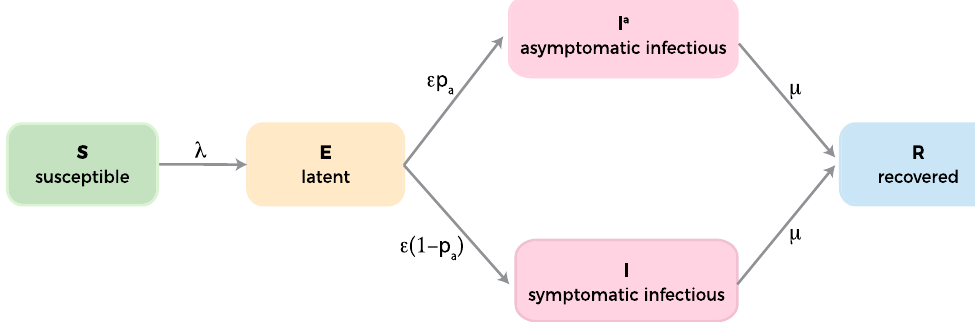
Figure 2. Flow diagram of the SEIR transmission model (boxes represent an SEIR compartment state and arrows represent the rate of transition from one state to another). A susceptible individual in each subpopulation (network node) contracts the infection at rate (cid:31) and enters the latent compartment. The individual is infected 1 but not infectious during the latent period ( ǫ − days). Latent individuals subsequently transition to being either asymptomatic infectious or symptomatic infectious with rates ǫ p a and ǫ( 1 − p a ) respectively. Infectious individuals recover permanently at rate µ .